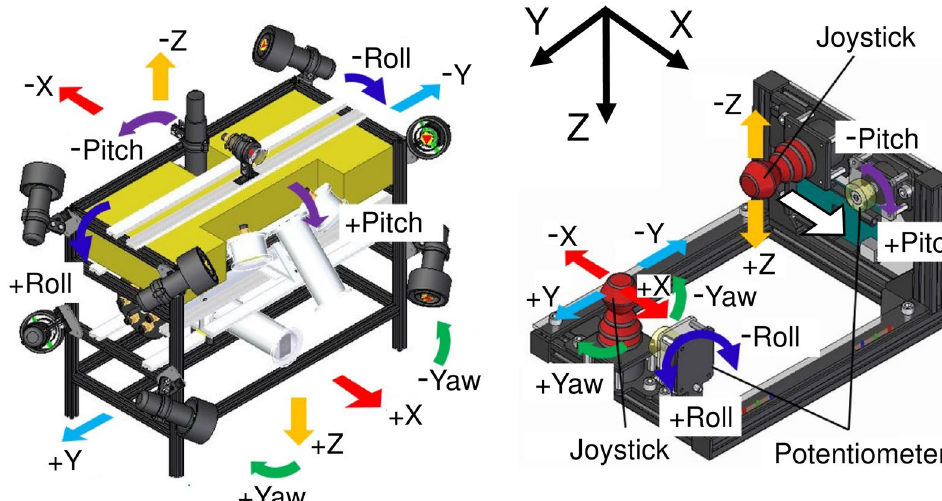
Fig. 14 Control device for the developed